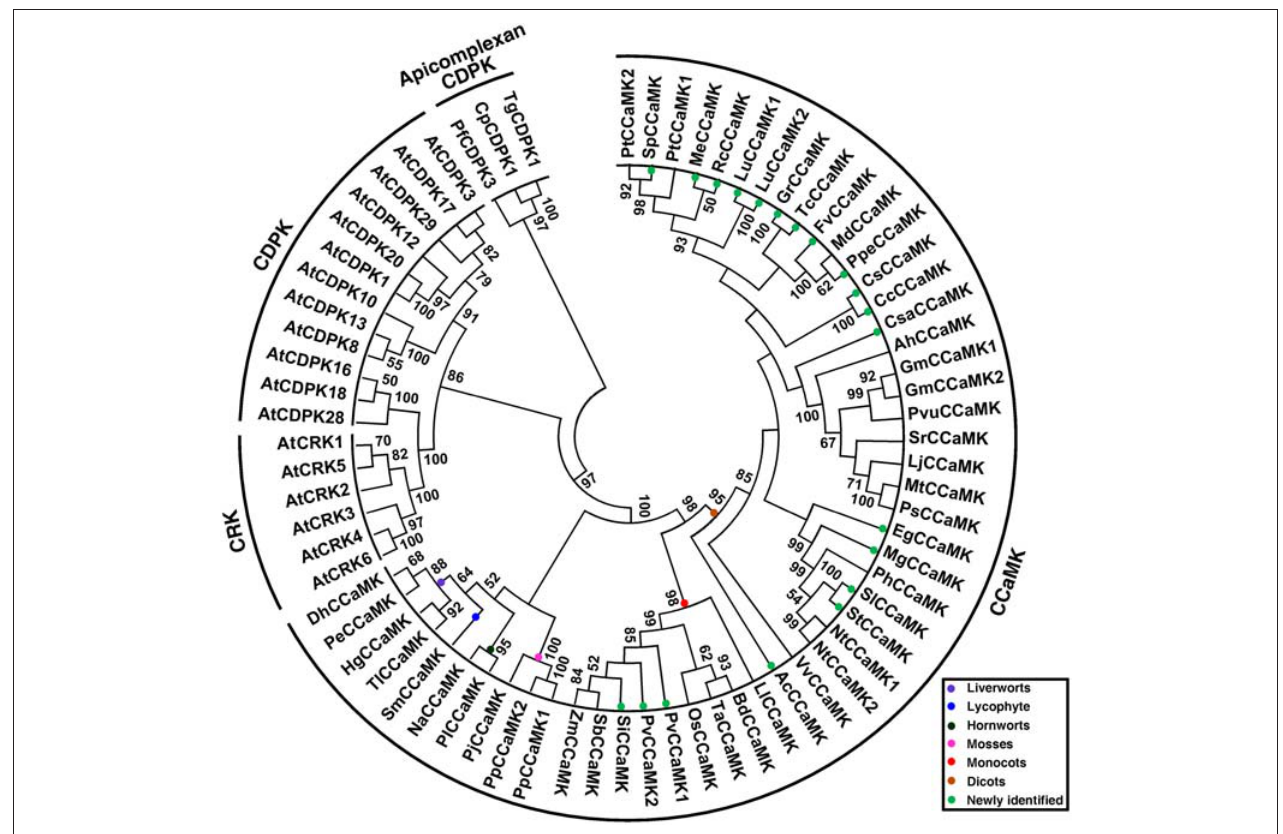
FIGURE 2 | Phylogenetic tree of plant CCaMK proteins. The tree was created based on alignment of full-length proteins using maximum likelihood (ML) method with bootstrap of 1000 in MEGA 5.0. Fifty-one CCaMKs identified from a wide variety of plant species at diversified evolutionary positions together with 21 CDPKs and CRKs (Table S1) were subjected to tree construction. Three apicomplexan CDPKs, TgCDPK1, PfCDPK3, and CpCDPK1, were included as outgroup. Different clades of CCaMKs from various taxonomic groups are indicated in different colors. The 18 species for which CCaMKs genes are newly identified in this study are marked with solid green